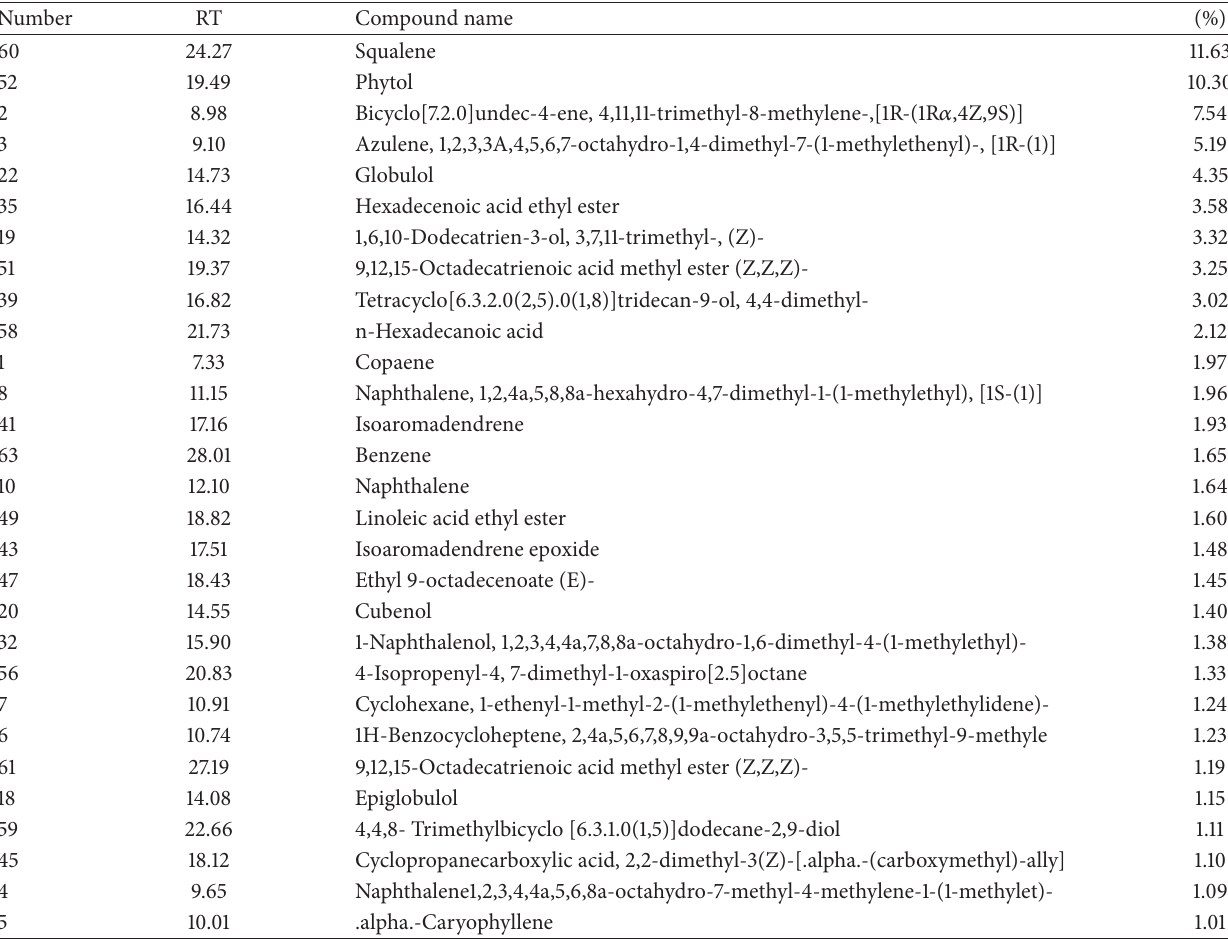
Table 2: Antimicrobial compounds, retention times, and percentages of methanol leaf extract of Psidium guajava analyzed by a gas chromatography-mass